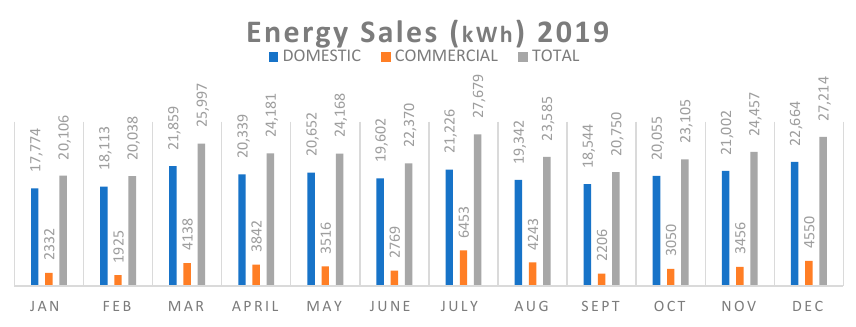
Figure 4. Energy Sales January–December 2020. Figure 5. Energy Sales January–July 2021. Figure 3 shows the sales made by KHMG to customers outside Kisiizi hospital, mak- ing a total of 241,170 kWh of domestic sales and 42,480 kWh of Commercial sales. The highest sales were in March, April, May, July, November, and December. This is due to school holidays when children are at home and spend time on television watching,